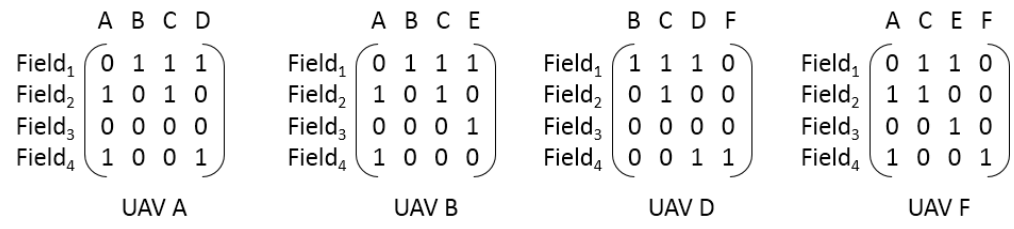
Figure 11. Part of the capability matrix of agent candidate.